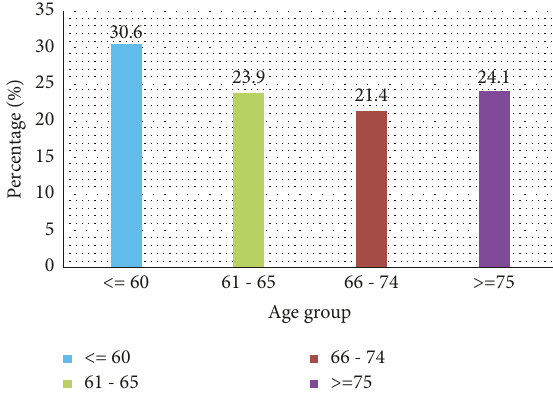
Figure 1: Percentage for the age group ( n � 415). Table 1: Frequency for prior treatment ( n � 415).